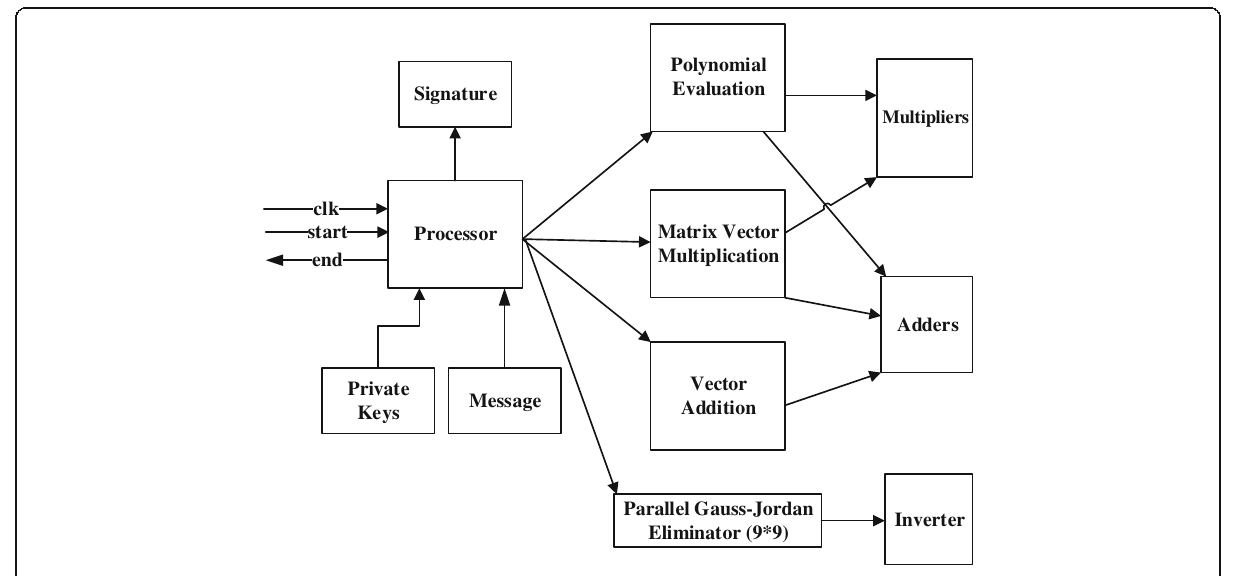
Fig. 2 Hardware architecture of multivariate